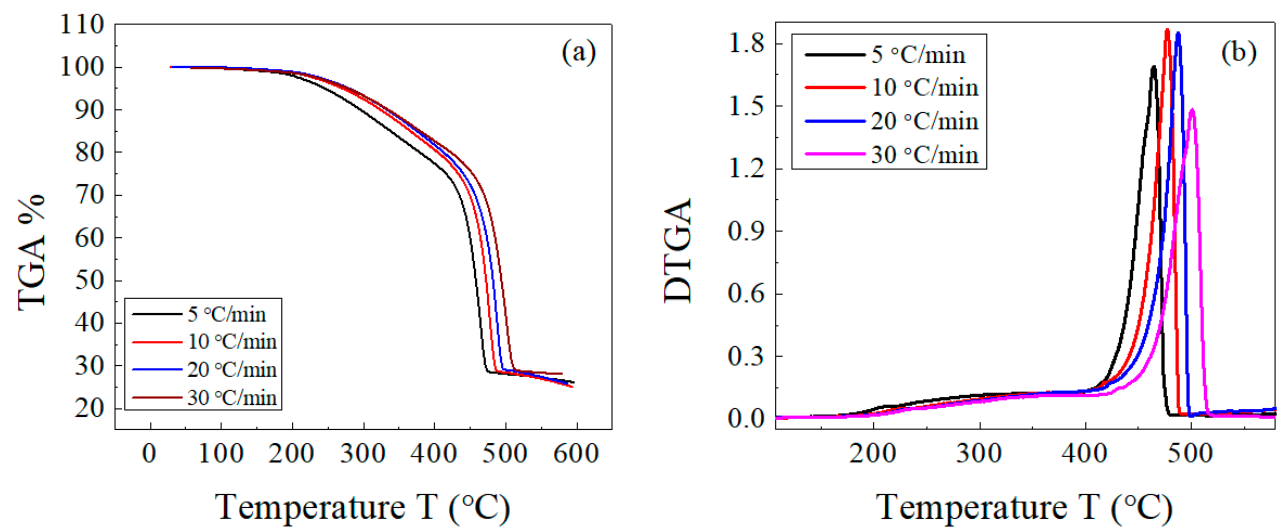
Figure 3. ( a ) TGA and ( b ) DTGA curves of EPDM host composite at different heating rates of 5, 10, 20, and 30 °C/min.